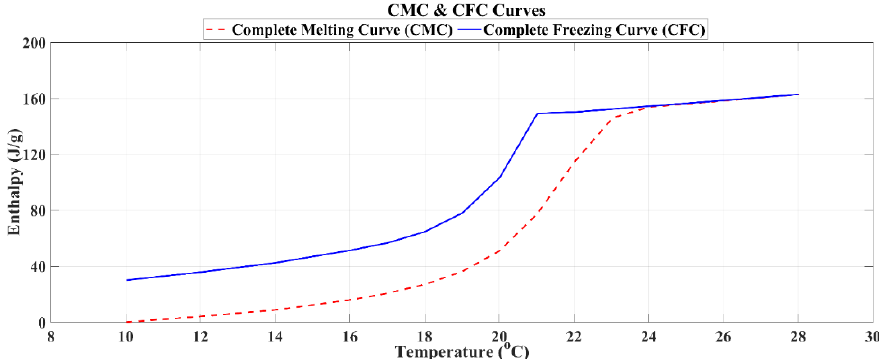
Figure 3. CMC and CFC temperature–enthalpy curves.